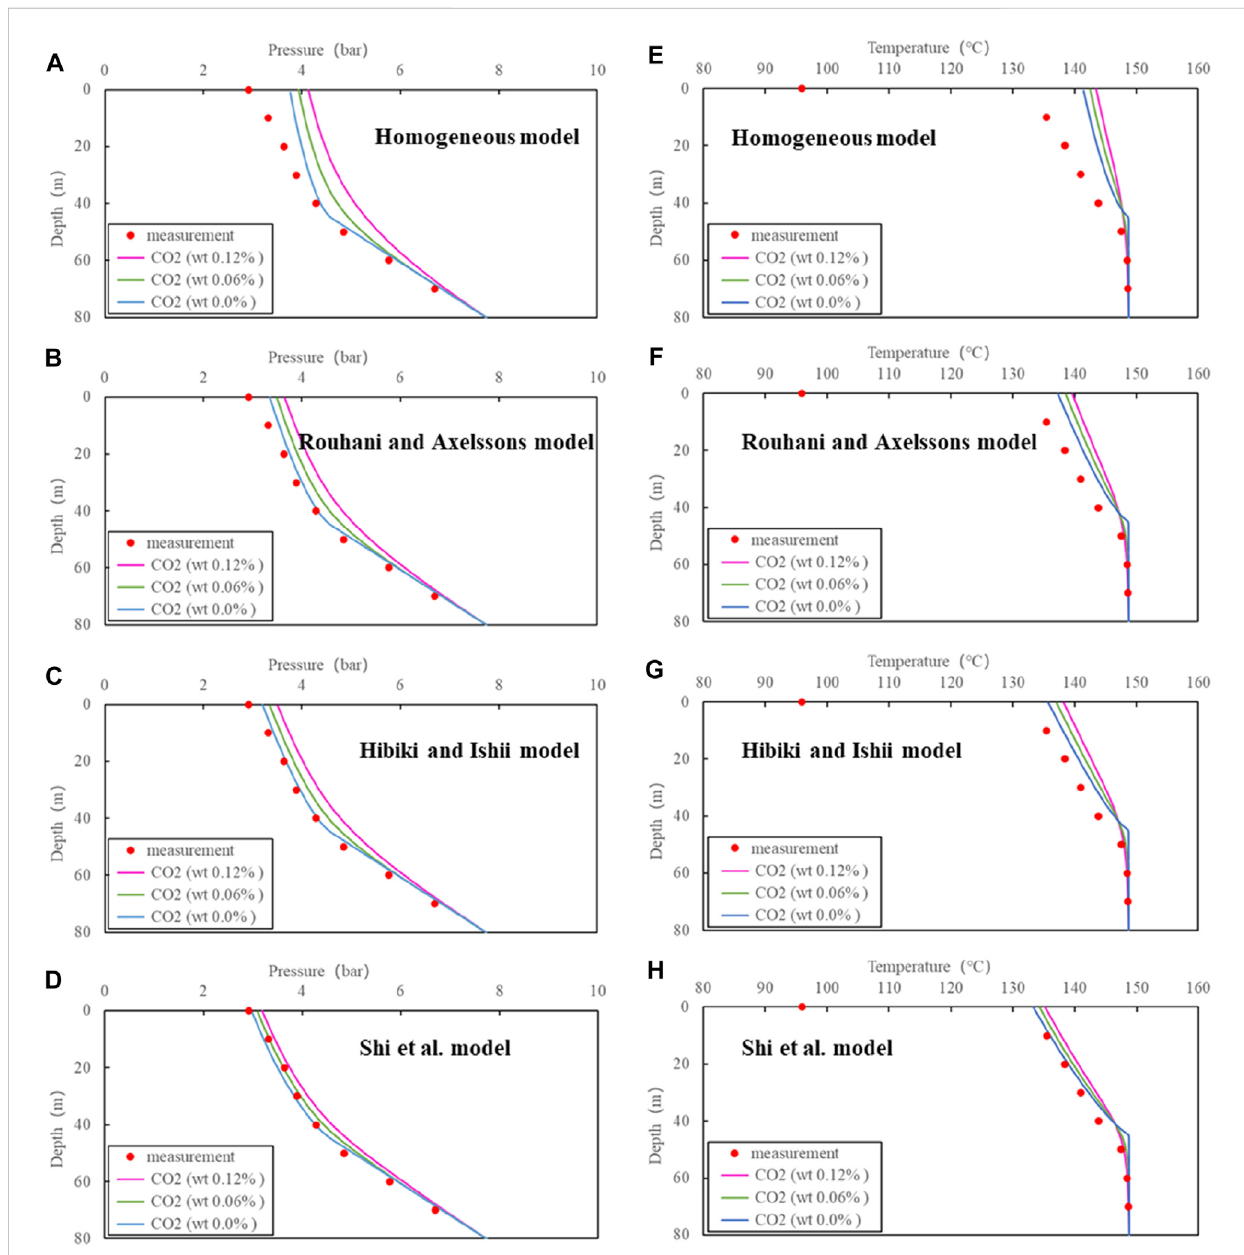
FIGURE 7 Comparison of simulations with different models and measurements for ZK324: (A) , (B) , (C) and (D) for pressure, (E) , (F) , (G) and (H) for temperature.